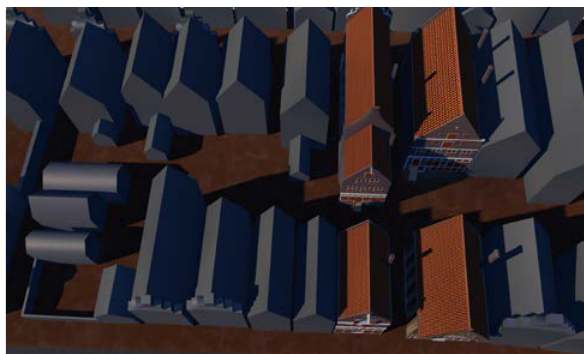
Figure 6. Reconstruction of the interior of the house of Occo (image L.